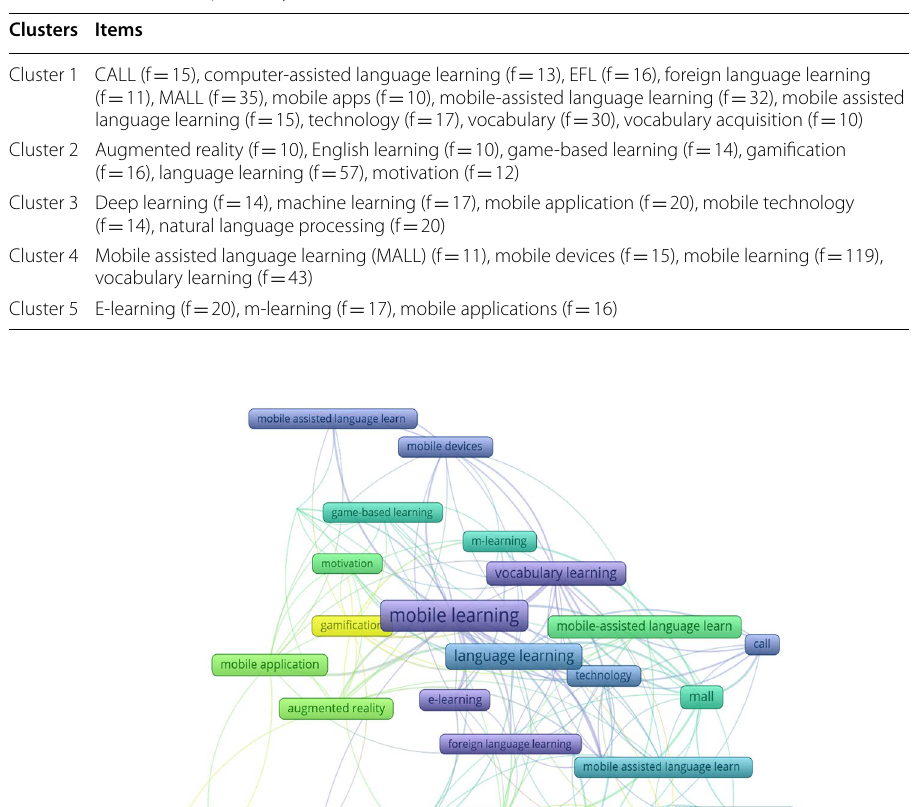
Table 3 points out that the most frequent keywords were mobile learning (f 119), = language learning (f 57), and vocabulary learning (f 43). It was observed that = = different names such as MALL, Mobile-Assisted Language Learning, and Mobile Assisted Language Learning (MALL) were used for the same concept. The same finding can be noted also in the dimensions of vocabulary (e.g. vocabulary, vocabu- lary learning and vocabulary acquisition), and language learning (e.g. EFL, foreign language learning, English learning, language learning).